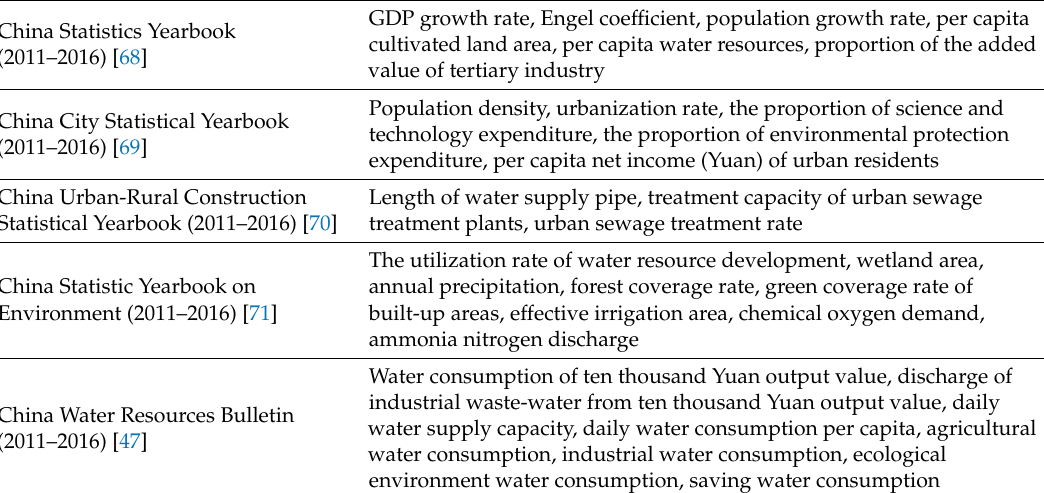
Table 2. The sources of the